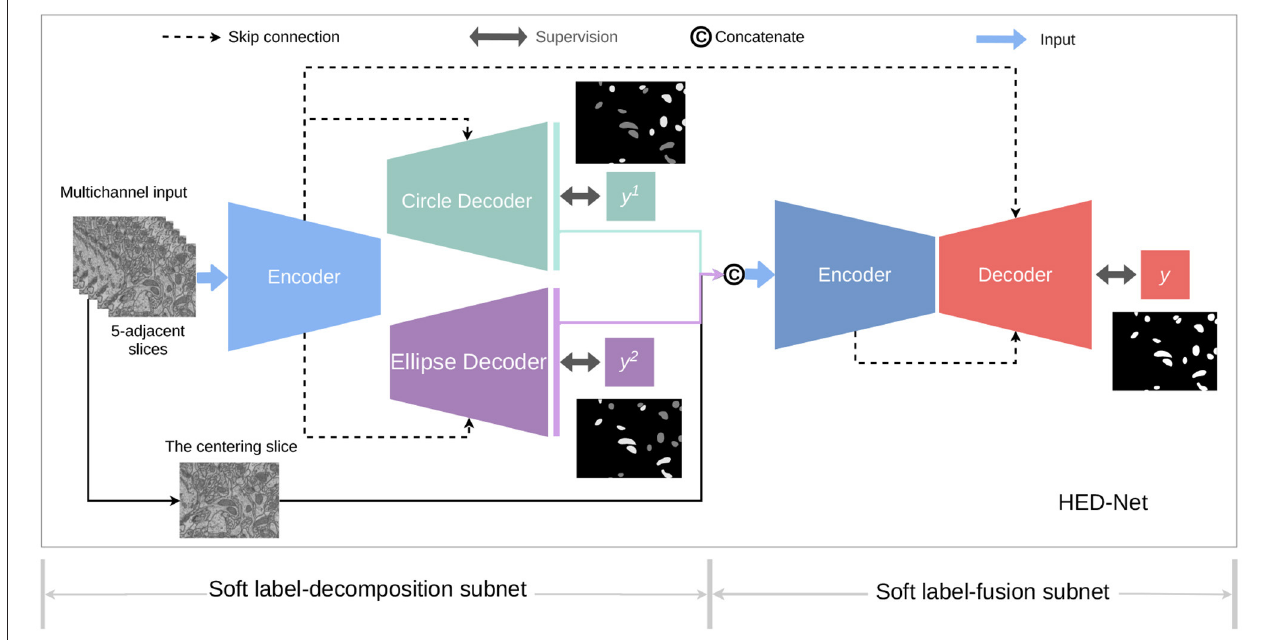
FIGURE 3 | An overview of the proposed HED-Net, which is a three-level nested encoder-decoder with micro U-Nets as the basic building blocks. The HED-Net consists of a soft label-decomposition stage and a soft label-fusion stage. The model is trained under the supervision of ground truth label maps and subcategory-aware label